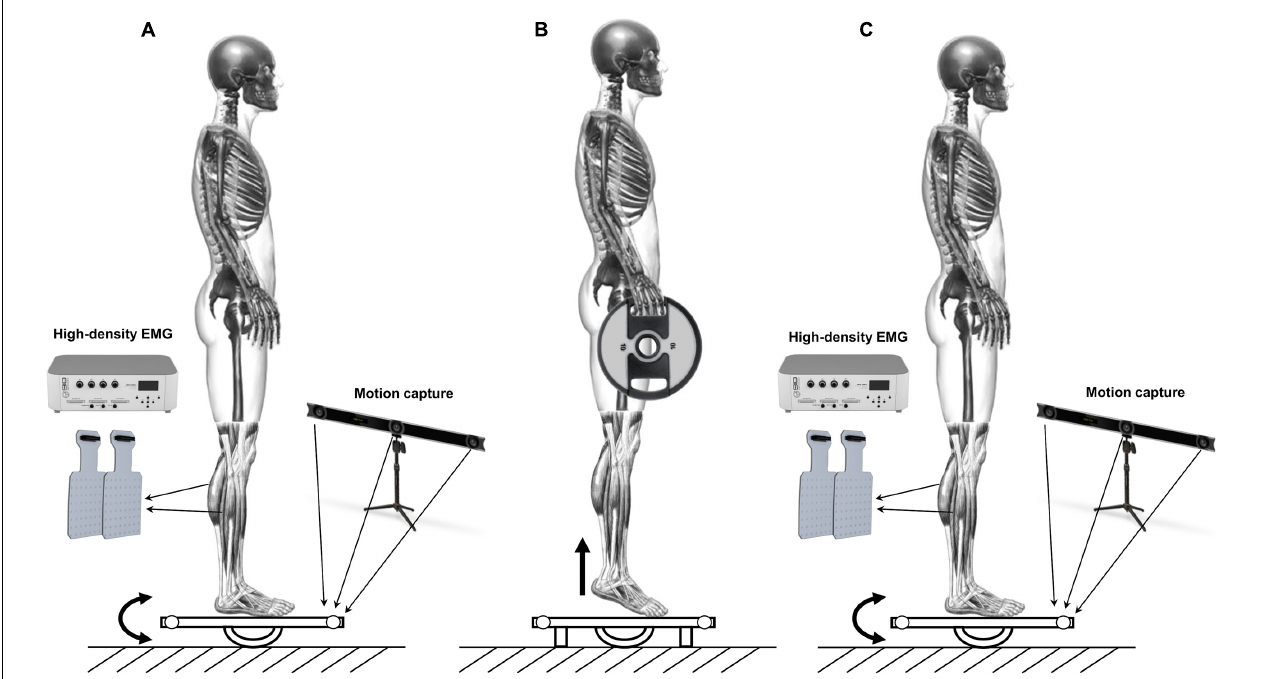
FIGURE 1 | Schematic representation of the experimental protocol. (A) 40 s trial on the oscillating platform. (B) Standing calf to failure gripping a 10 kg disk on each hand. (C) 40 s trial on the oscillating platform after the fatigue protocol.